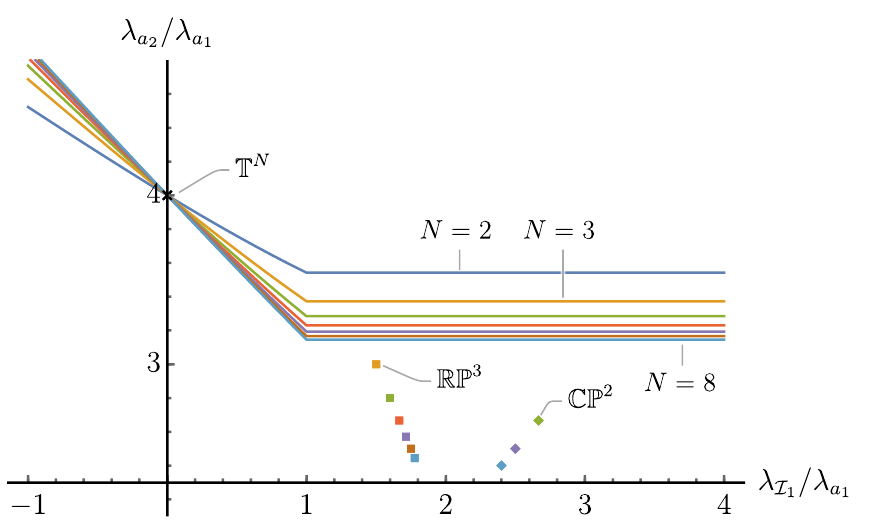
Figure 1 . Upper bounds on the ratio of the (cid:12)rst distinct nonzero eigenvalues of the scalar Laplacian on closed Einstein manifolds with R (cid:21) 0 and N = 2 ; : : : ; 8 for di(cid:11)erent values of the smallest Lich- nerowicz eigenvalue of transverse traceless tensors. The square and diamond markers correspond to RP N and CP N= 2 with their standard metrics and the cross corresponds to long (cid:13)at N -tori. of the bound found in ref. [12] and is saturated by (cid:13)at tori whose (cid:12)rst eigenvalues